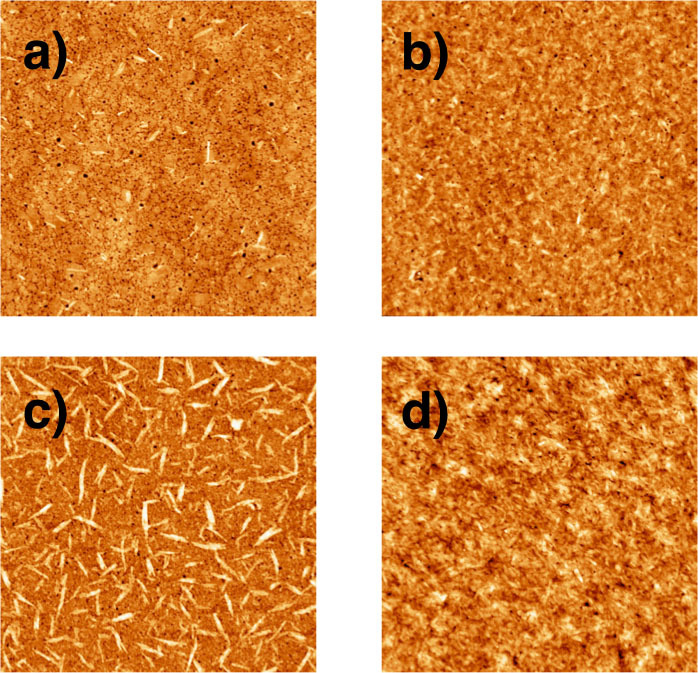
AFM images (5 × 5 μm) of 3:2 DPP(TBFu)2:MIF films (a,b) and DPP(TBFu)2:PC61BM (c,d) before (a,c) and after (b,d) solvent vapour annealing.